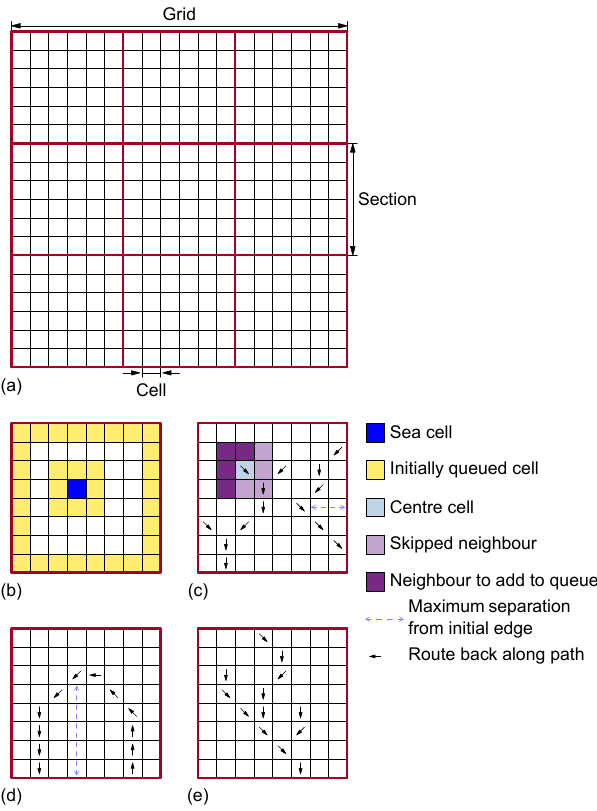
Figure 3. Diagrams illustrating various aspects of the orography upscaling algorithm. In panel (a) , the division of a DEM grid into sections is shown; the upscaling algorithm processes each section separately to produce an effective hydrological height for each sec- tion. Panel (b) shows the initial cells (see main text of Appendix A) added to the queue at the start of the algorithm including the neigh- bours of a sea point. Panel (c) shows three paths: two complete but rejected because they do not meet the selection criteria (see main text) for a valid lowest path, and one incomplete. The short path in the bottom left corner is complete but its length is too short for it to qualify as the lowest valid path through the cell; the longer path on the right is also complete but it returns to the same edge it started at without having met the required maximum separation from the initial edge threshold. The path in the middle, which branches from the short path in the bottom left, is incomplete and a cell at its end is undergoing processing. Half this cell’s neighbours have been added to the queue; the other half have been skipped because they have already been processed. In panel (d) , we show a valid lowest path through the cell that returns to its initial edge but meets both of the selection criteria, while in panel (e) , we show a valid lowest path through the cell that spans two different edges and has several in- complete paths branching off